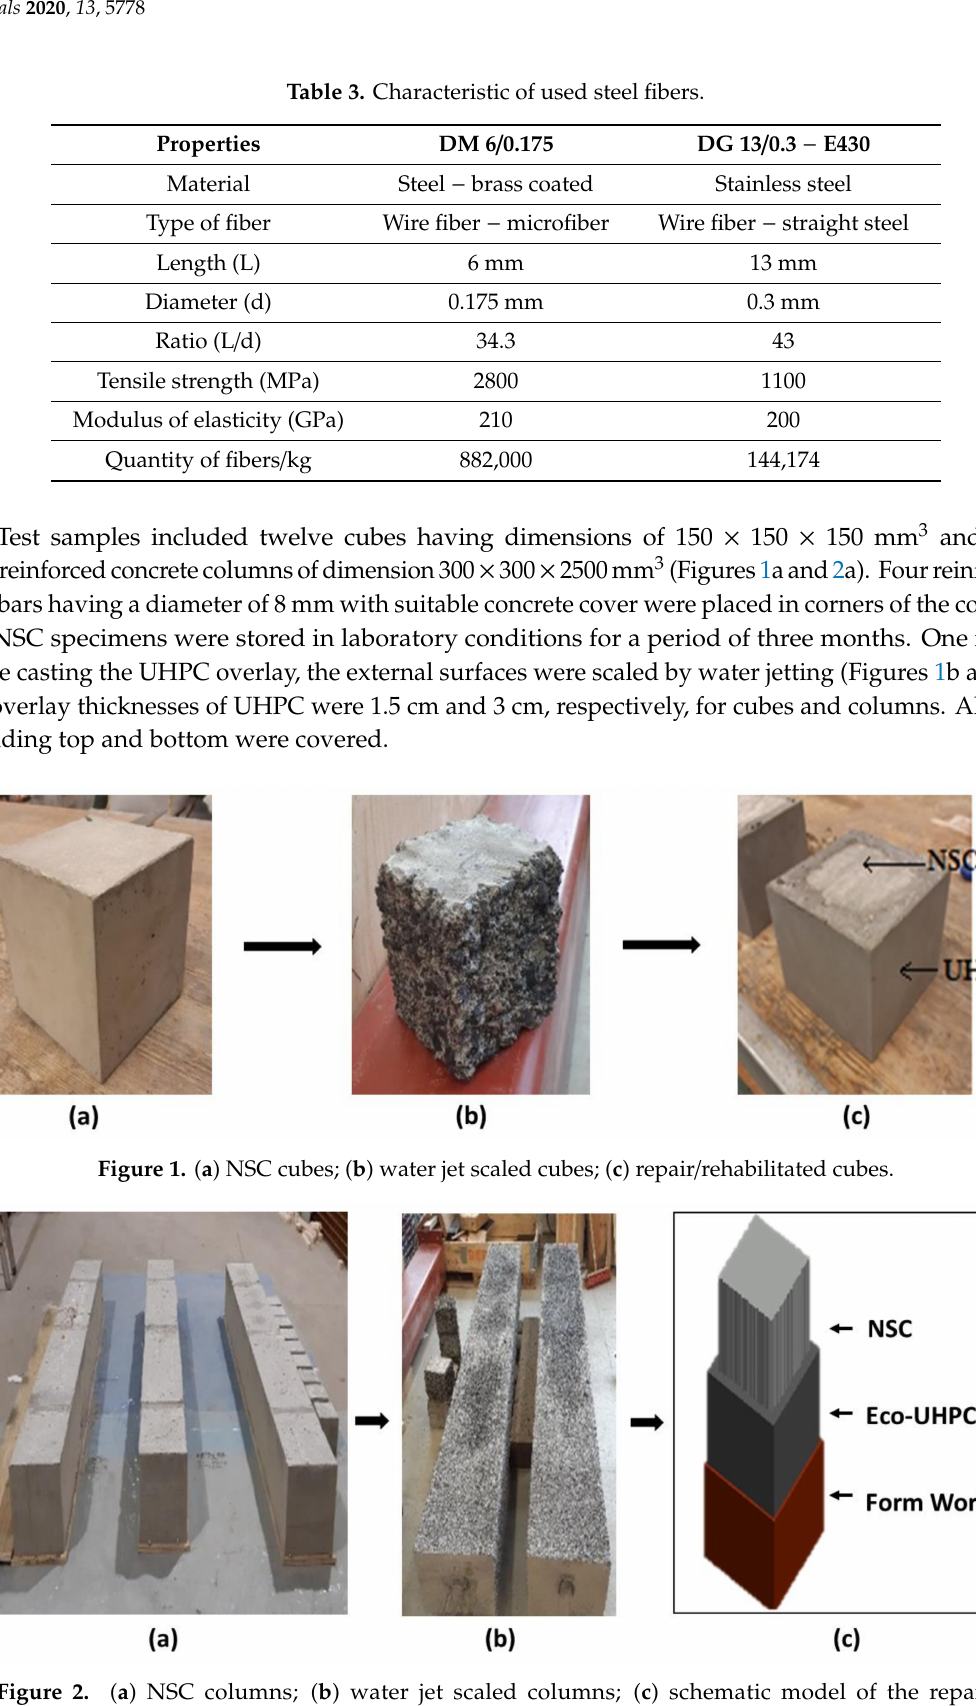
Figure 2. ( a ) NSC columns; ( b ) water jet scaled columns; ( c ) schematic model of the repair / rehabilitated